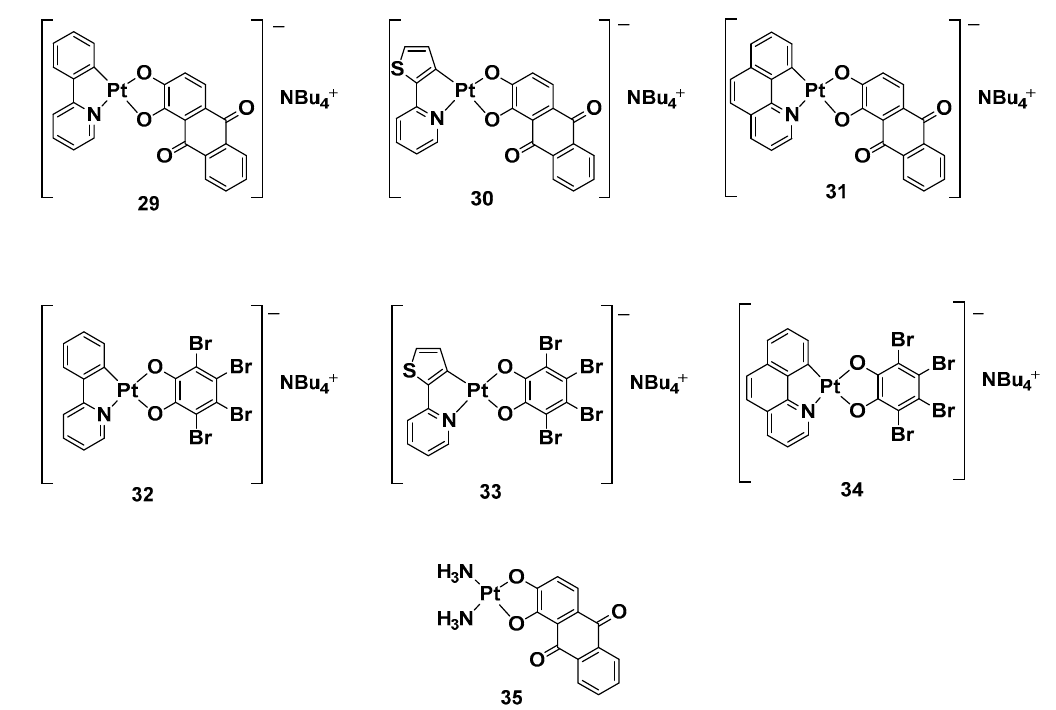
Figure 13. Anionic Pt(II) complexes, 29 – 35 .